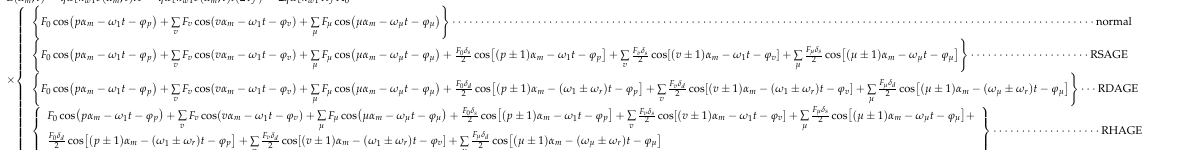
In Equation (9), k y 1 is the fundamental wave pitch factor, k q 1 is the fundamental wave distribution factor, α 1 is the slot angle, and y is the stator winding